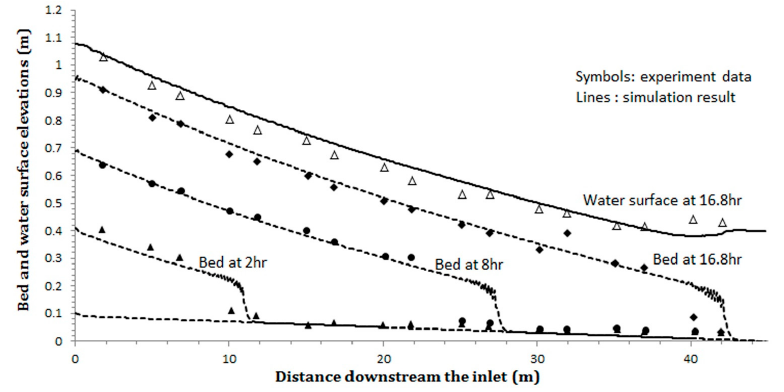
Figure 1. Predicted bed elevations and water surface of the experiment of Seal et al. [46].